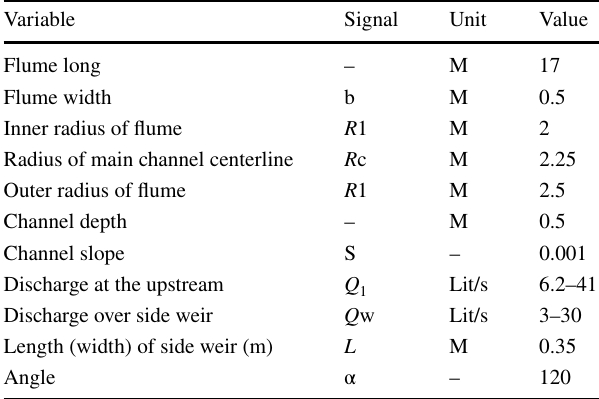
Table 2 The variables related to the